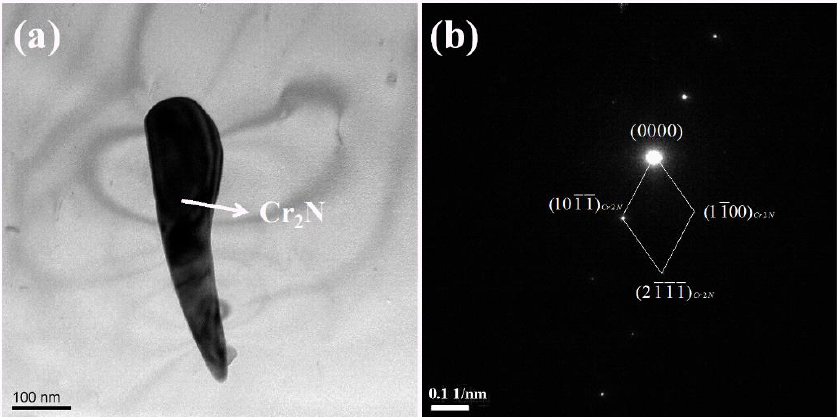
Figure 4. TEM characterization of Cr 2 N in the DSS 2002 specimen with a heat input of 5 kJ/cm: ( a ) a bright-field image; ( b ) diffraction pattern.